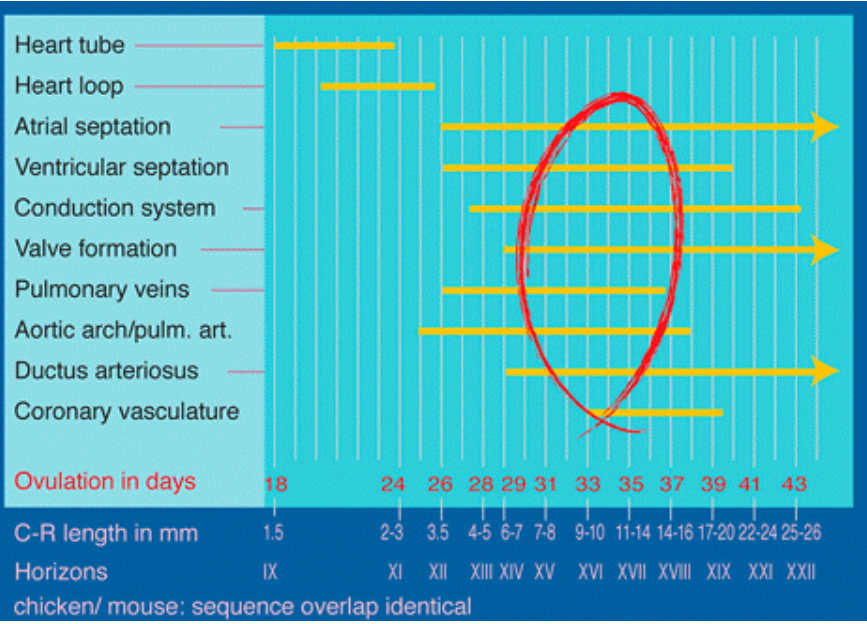
FIGURE 1. Schematic overview of the time span of development of the different cardiac components. Development of the CCS is narrowly related to the development of the cardiac chambers and vascular system.